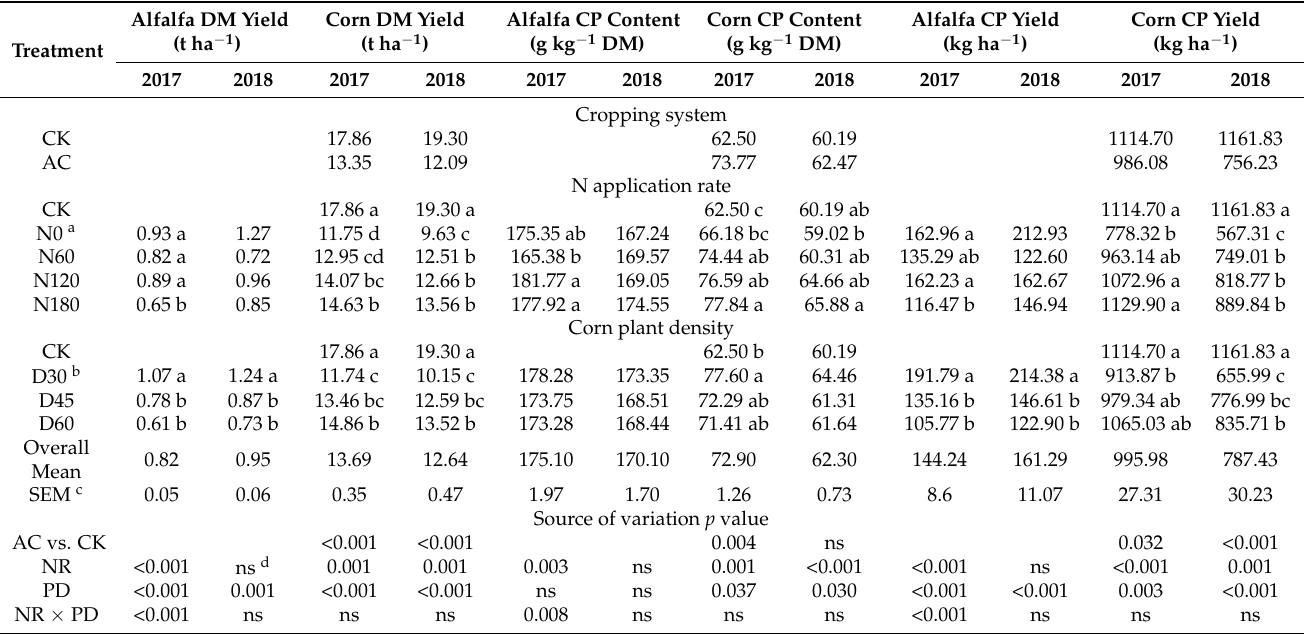
Table 2. Forage dry matter (DM) yield, crude protein (CP) content, CP yield of alfalfa–silage corn relay intercropping (AC) and silage corn monoculture control (CK) as affected by nitrogen application rate (NR) and corn plant density